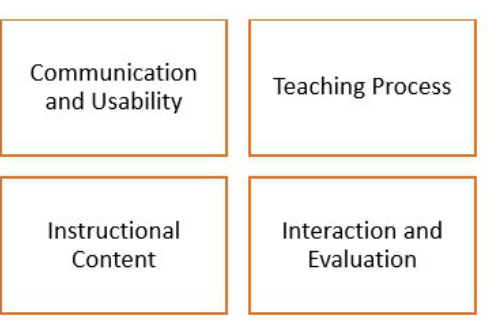
Figure 2. e-Satisfaction scale